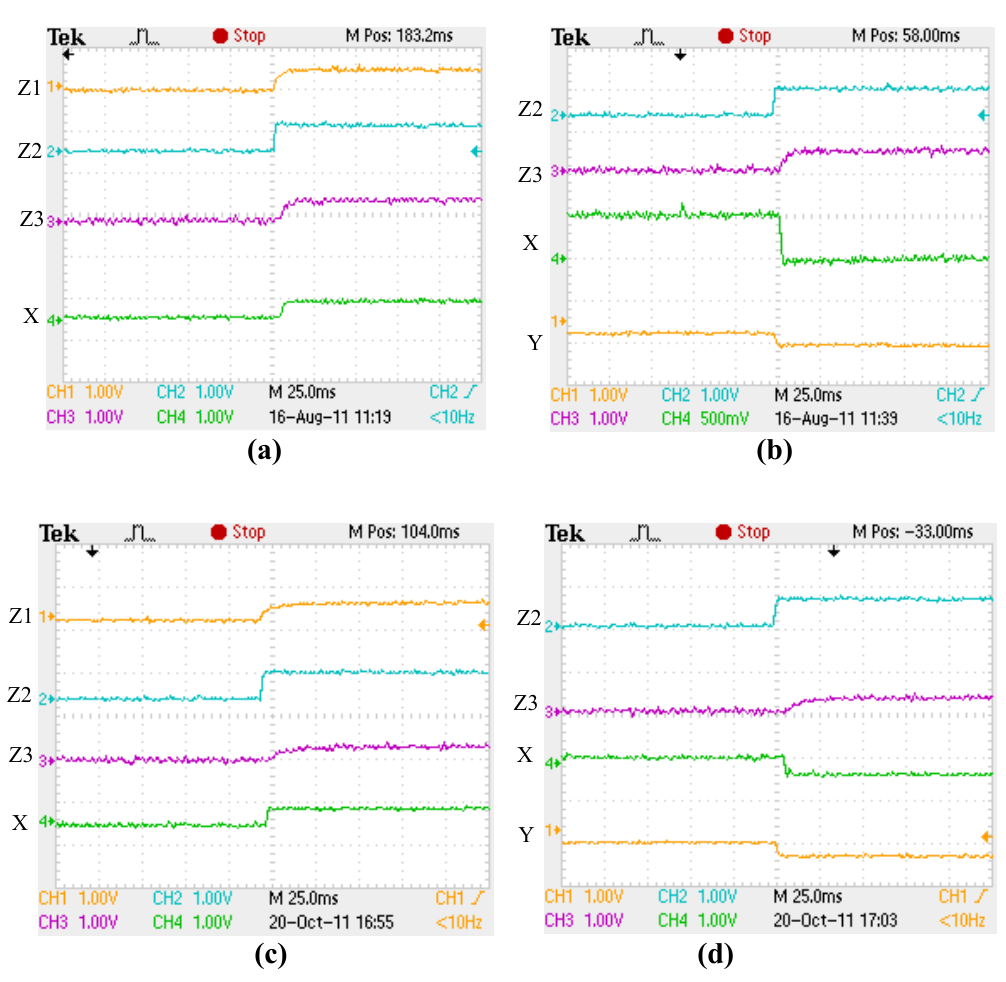
Figure 14. Electrostatic levitation displacement curves of the proof mass: (a) Curves for Z1, Z2, Z3 and X positions; (b) Curves for Z2, Z3, X and Y positions; (c) and (d) repetitions of levitation displacement curves of (a) and (b) after about two